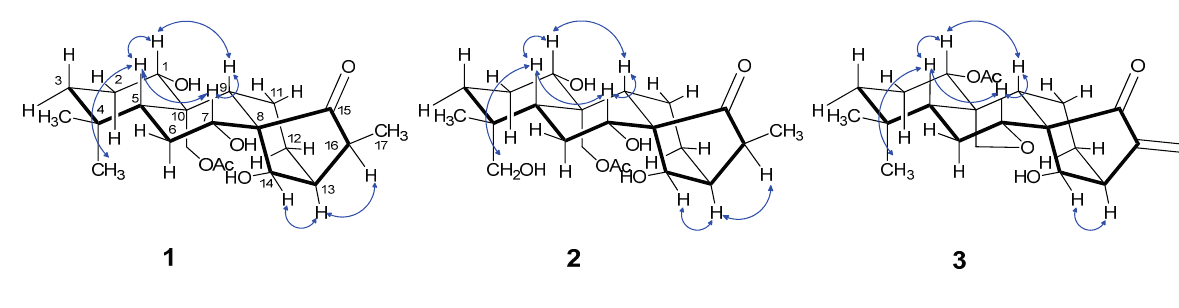
Figure 2. Key HMBC and 1 H- 1 HCOSY correlations for compounds 1 – 3 .